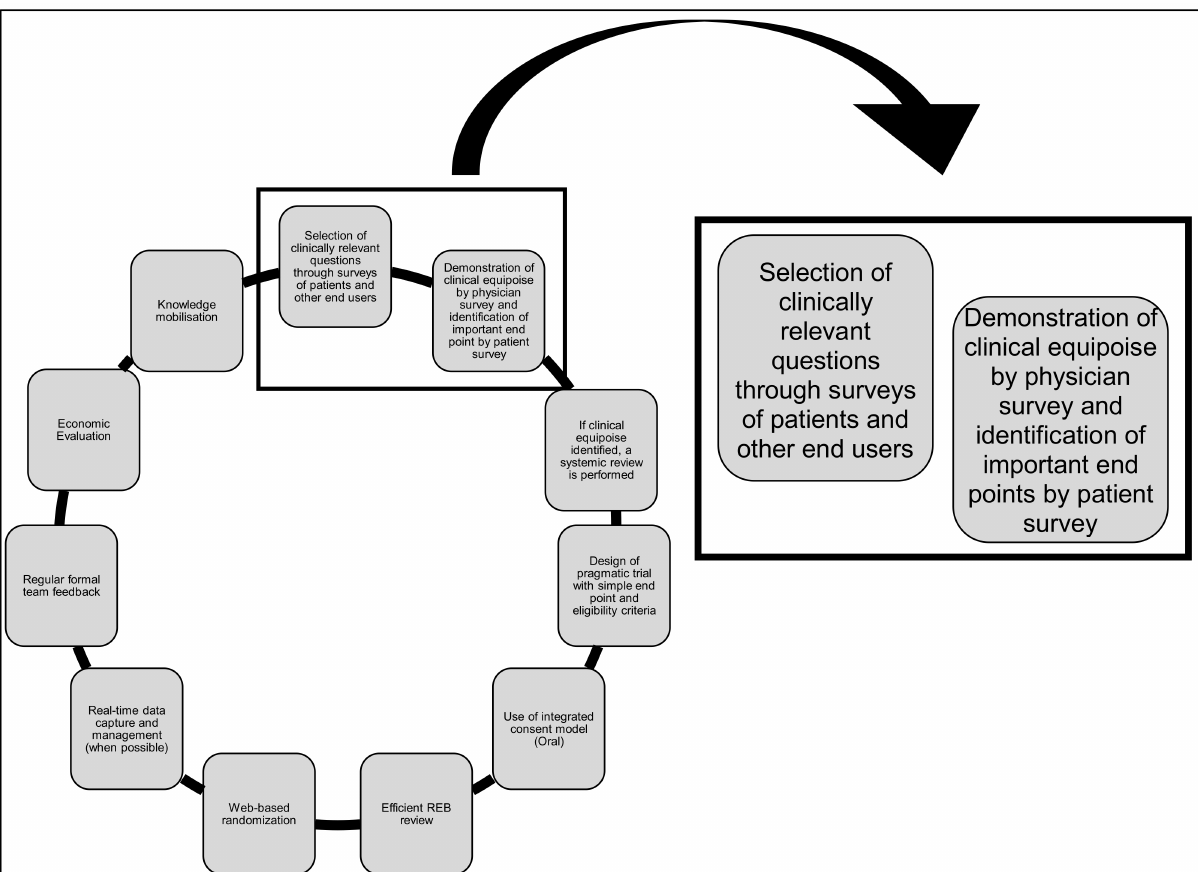
Figure 1. Key tenants for the REaCT Program (adapted with permission from